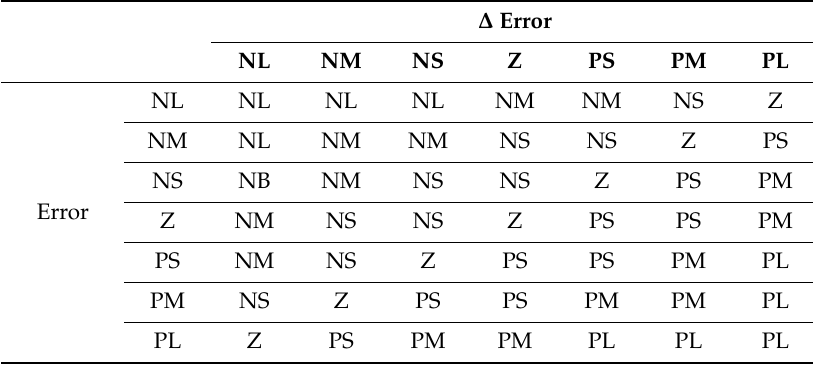
Table 2. Fuzzy logic rule table.